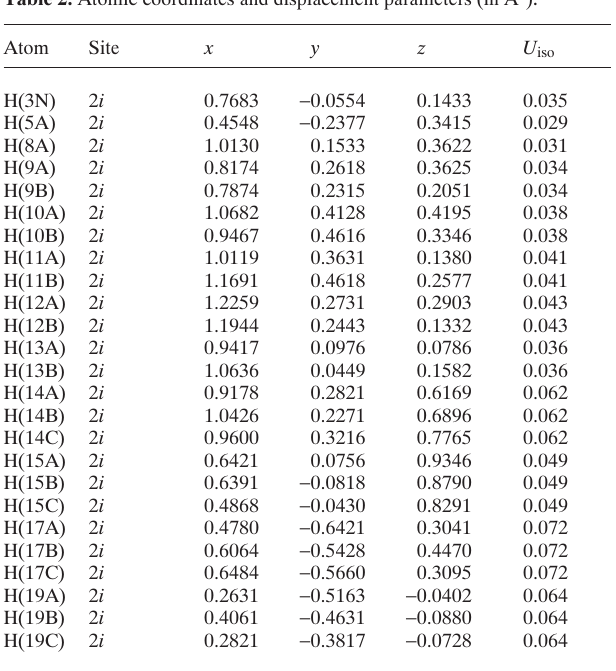
Table 2. Atomic coordinates and displacement parameters (in Å 2 )